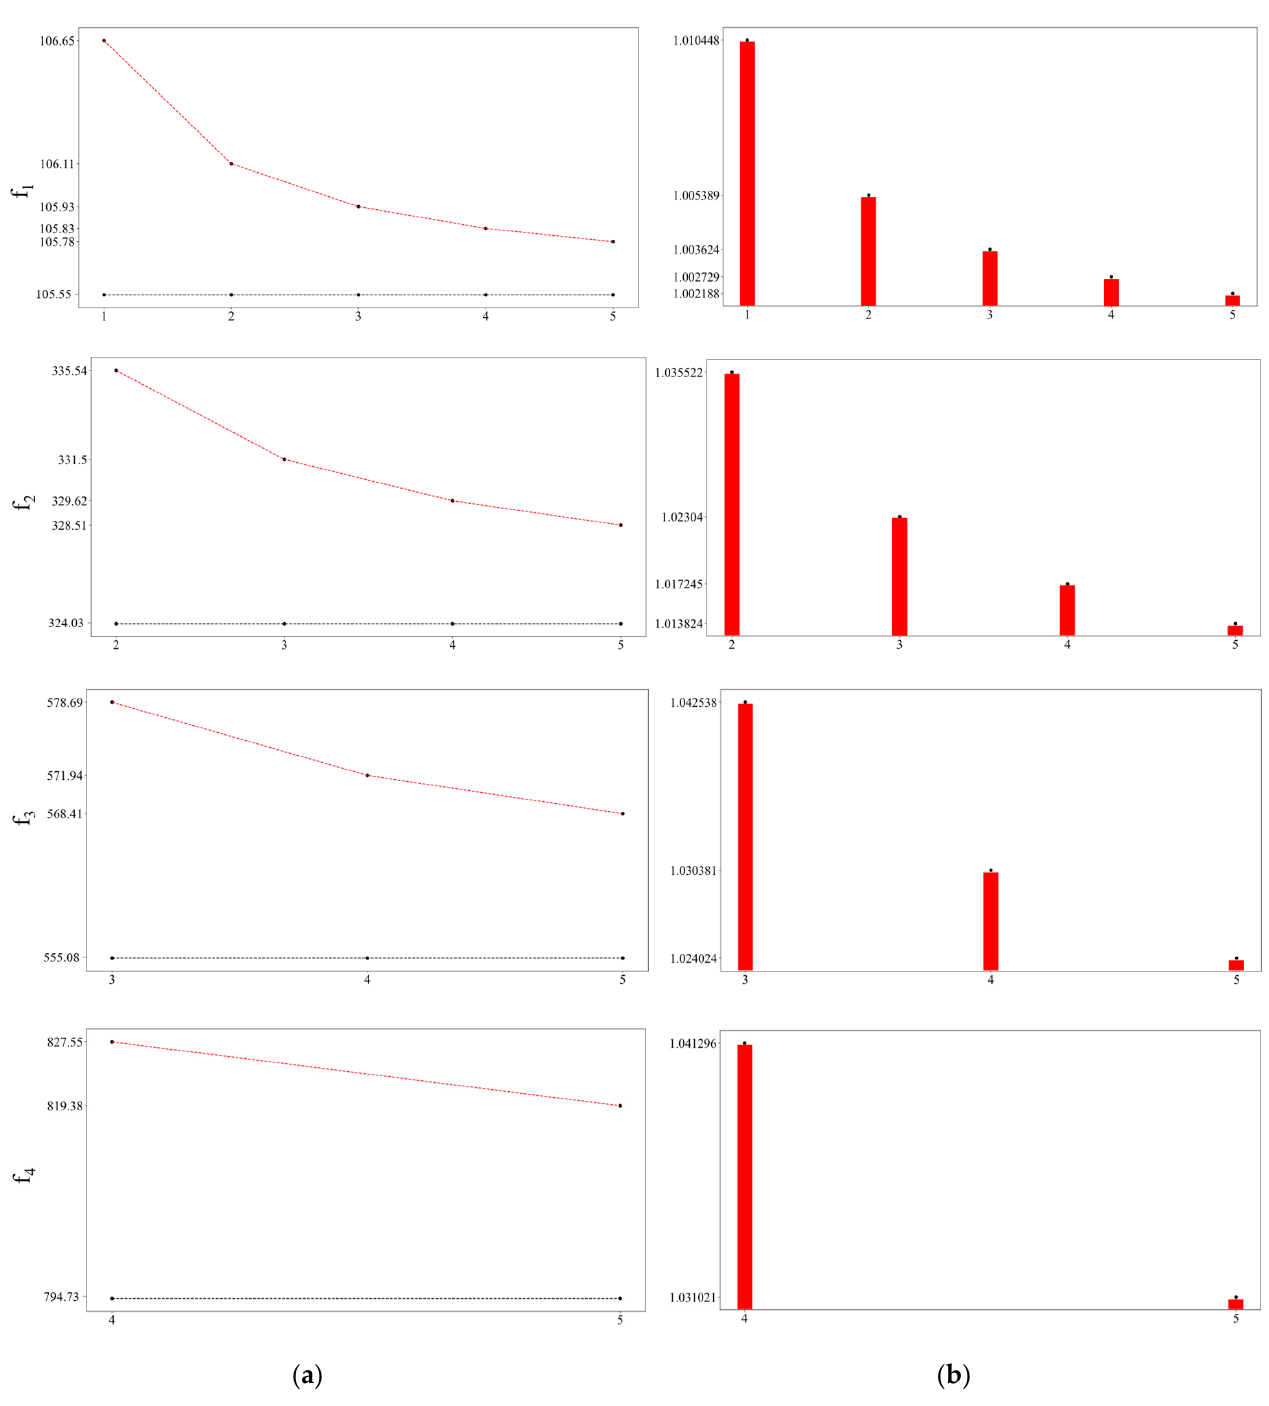
Figure 4. The first four eigenfrequencies of the pylon with an attached transient mass for mass ratio 𝑅 = 0.20 and at time 𝑡 = 0 : ( a ) Left column plots the eigenfrequencies as the number of iterations increases (red color) and the exact values (black color); ( b ) right column plots the corresponding rate of convergence.